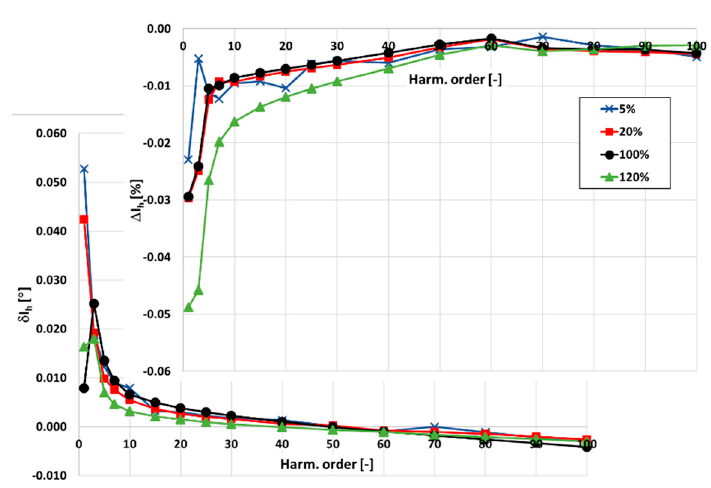
Figure 4. The values of current and phase errors at harmonics of the designed wideband CT for secondary current 5 A, rated load, and 5%, 20%, 100%, 120% of rated primary current.